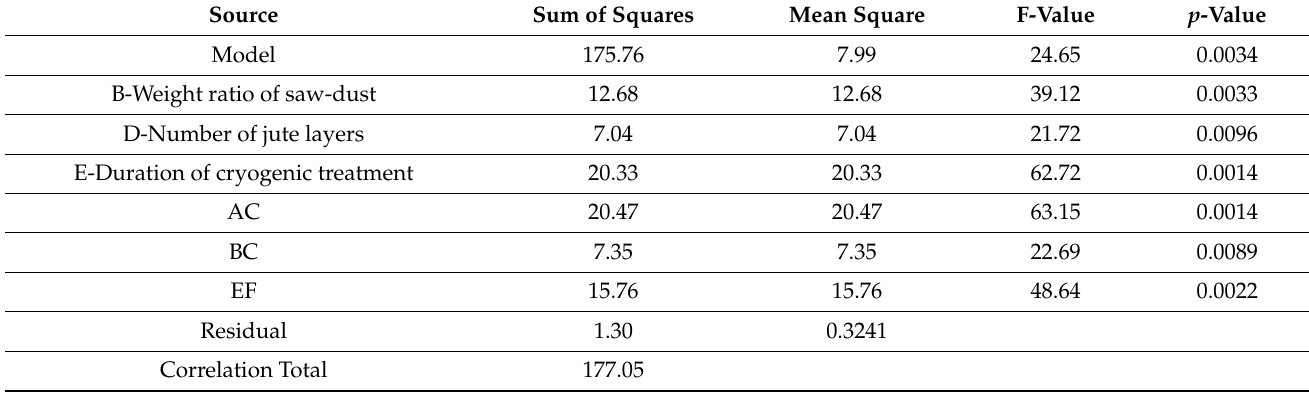
Table 5. Results of ANOVA for tensile strength including only the significant parameters.